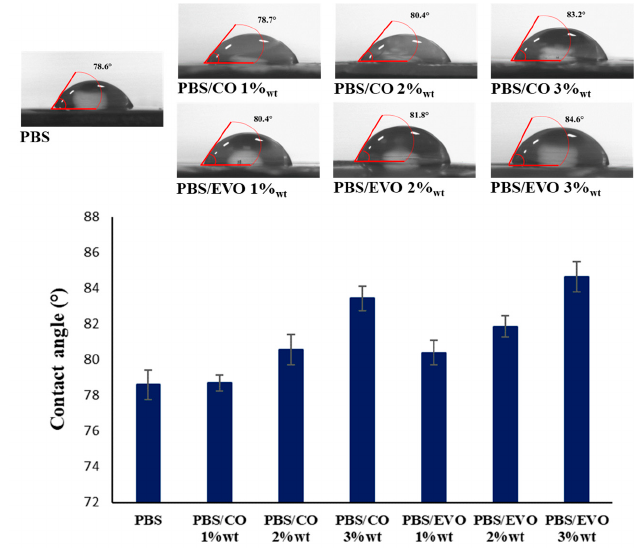
Figure 8. Contact-angle values for PBS and